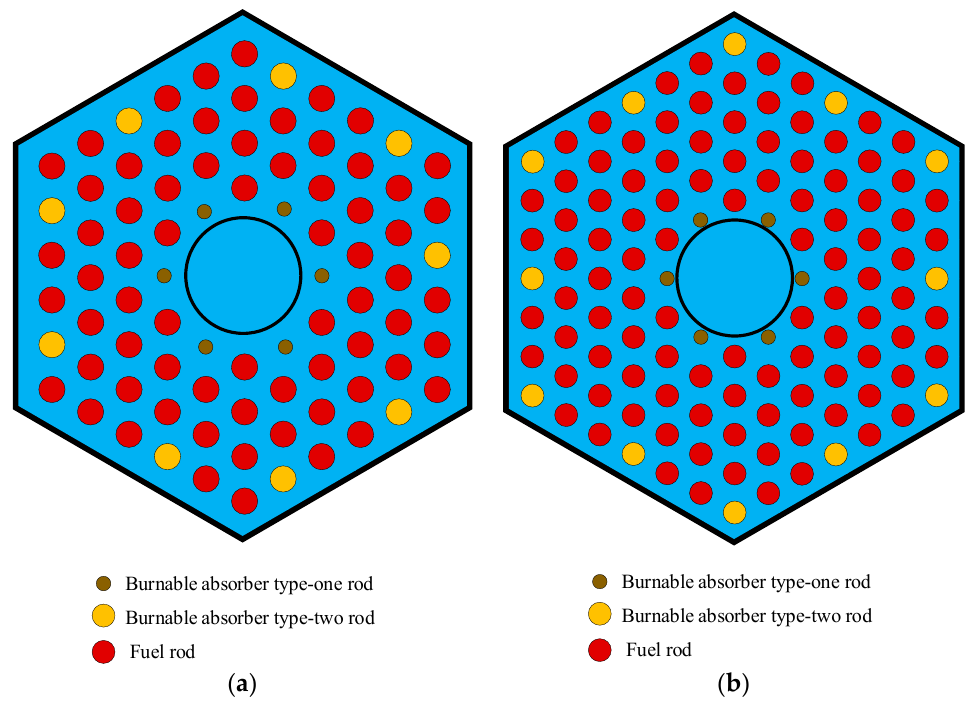
Figure 1. Scheme of KLT − 40S fuel assembly. ( a ) Four − ring fuel assembly; ( b ) five − ring fuel assembly.